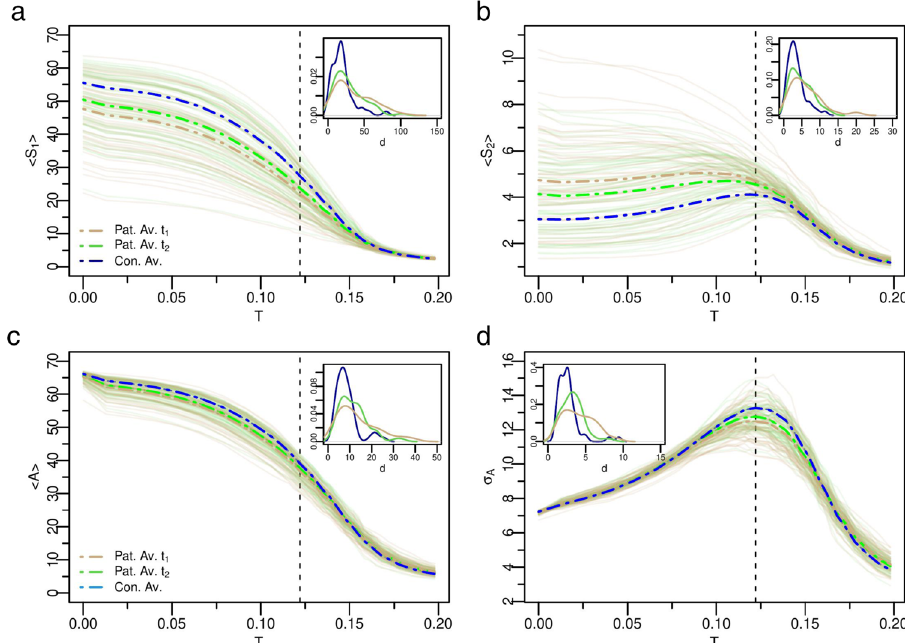
Fig. 3 Variability of the neural dynamics criticality across groups and time points. a , b Group based analysis of neural activity patterns, S 1 and S 2 , as a function of T for all patients and controls. The brown lines represent patients at t 1 (3 months post-stroke, n = 54), and the green lines at t 2 (12 months post- stroke, n = 59). The thin solid curves indicate each individual stroke patient, while the thick dashed lines represent the group average. The group analysis reveals that on average patient's neural activity patterns are abnormal at t 1 , but approach control levels at t 2 . c , d Average activity and standard deviation of activity, respectively. Note improvement of the activity and its variability across time points. Insets: Probability distribution function (pdf) of the Euclidean distances d in individual age-matched-controls and stroke patients at t 1 (brown) and t 2 (green). Patients at t 1 show greater variability of model neural activity as depicted by the longer pdf's tails. Note trend toward normalization from t 1 to t 2 . The black vertical dashed line depicts the critical point of healthy controls. Source data are provided as a Source Data fi